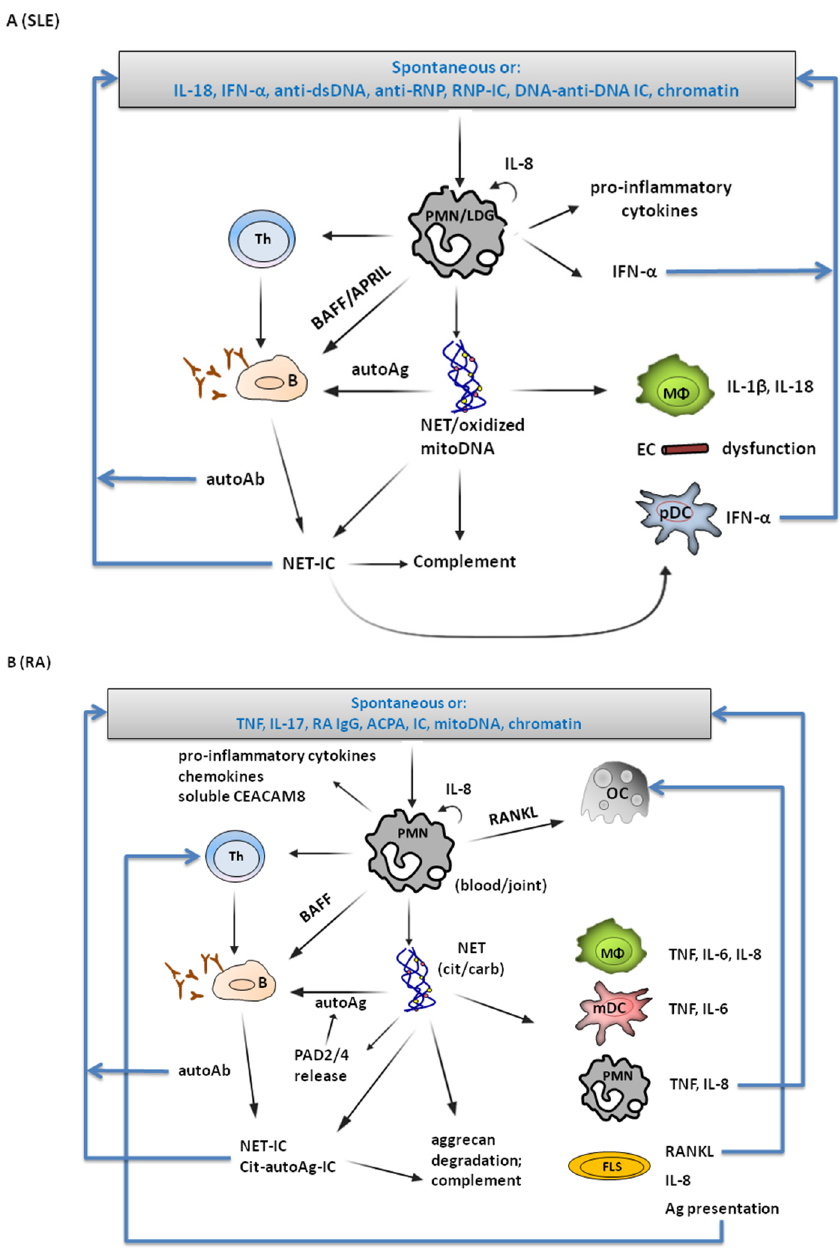
Figure 1. Potential pathogenic mechanisms involving PMNs and NETs in SLE ( A ) and RA ( B ). PMNs are activated either spontaneously or in response to disease-associated stimuli, potentially leading to NET formation. The consequences of PMN activation (e.g., antigen presentation, cytokine secretion) and NET formation (e.g., release of immunomodulatory molecules and autoantigens, potentially modified, such as by released PADs) on different cell types and activation of the complement system are depicted. NETs (modified or not) may act directly or via NET-containing immune complexes. Amplification loops are shown. The figure focuses on PMNs and NETs; other pathogenic mechanisms are involved. The downstream consequences of cytokines, immune complexes or activated target cells are not presented. ACPA, anti-citrullinated protein antibody; Ag, antigen; autoAb, autoantibody; autoAg, autoantigen; B, B lymphocyte; carb, carbamylated; cit, citrullinated; ds, double-stranded; EC, endothelial cell; FLS, fibroblast-like synoviocyte; IC, immune complex; IFN, interferon; IgG, immunoglobulin G; IL, interleukin; LDG, low-density granulocyte; mDC, myeloid dendritic cell; mitoDNA, mitochondrial DNA; M Φ , macrophage; OC, osteoclast; PAD, peptidyl-arginine deiminase; pDC, plasmacytoid dendritic cell; RNP, ribonucleoprotein; Th, T-helper lymphocyte; TNF, tumor necrosis factor.